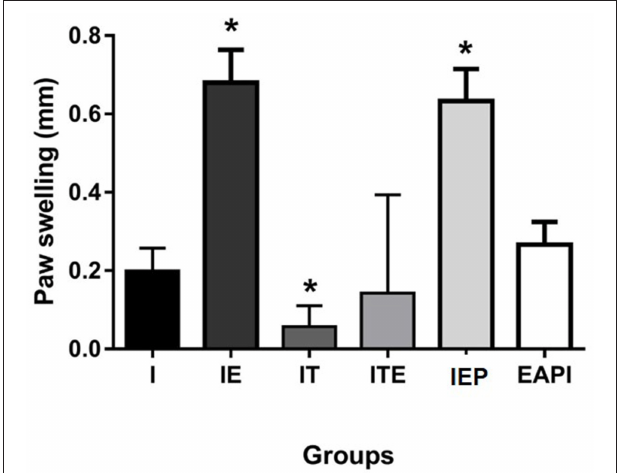
FIGURE 3 | Delayed type hypersensitivity (DTH) to total Leishmania major antigen in BALB / c mice trained and/or treated with Glucantime ® . DTH was carried out in the 13th week, at the end of the experiment. The DTH was evaluated using 20 µ g of total L. major antigen in 20 µ L of saline inoculated into the contralateral non-infected paw. Results obtained after 48h of antigen inoculum of L. major. Values are expressed as mean ± SD. Data were analyzed by one-way ANOVA followed by Tukey’s multiple comparison test. * P < 0.05 compared to (I).